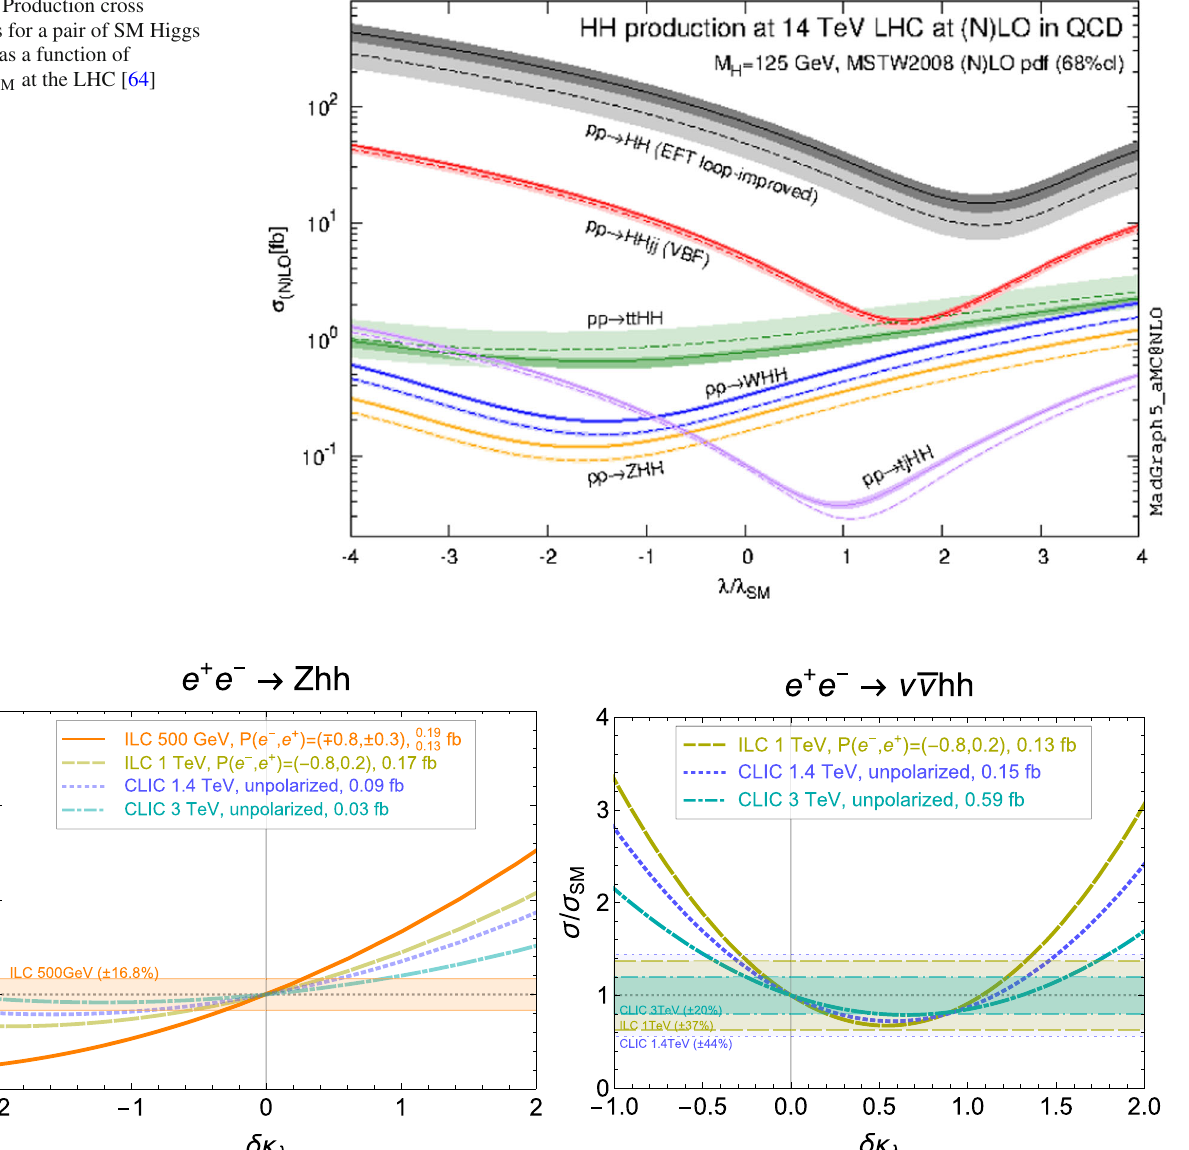
Fig. 1 Production cross sections for a pair of SM Higgs bosons as a function of